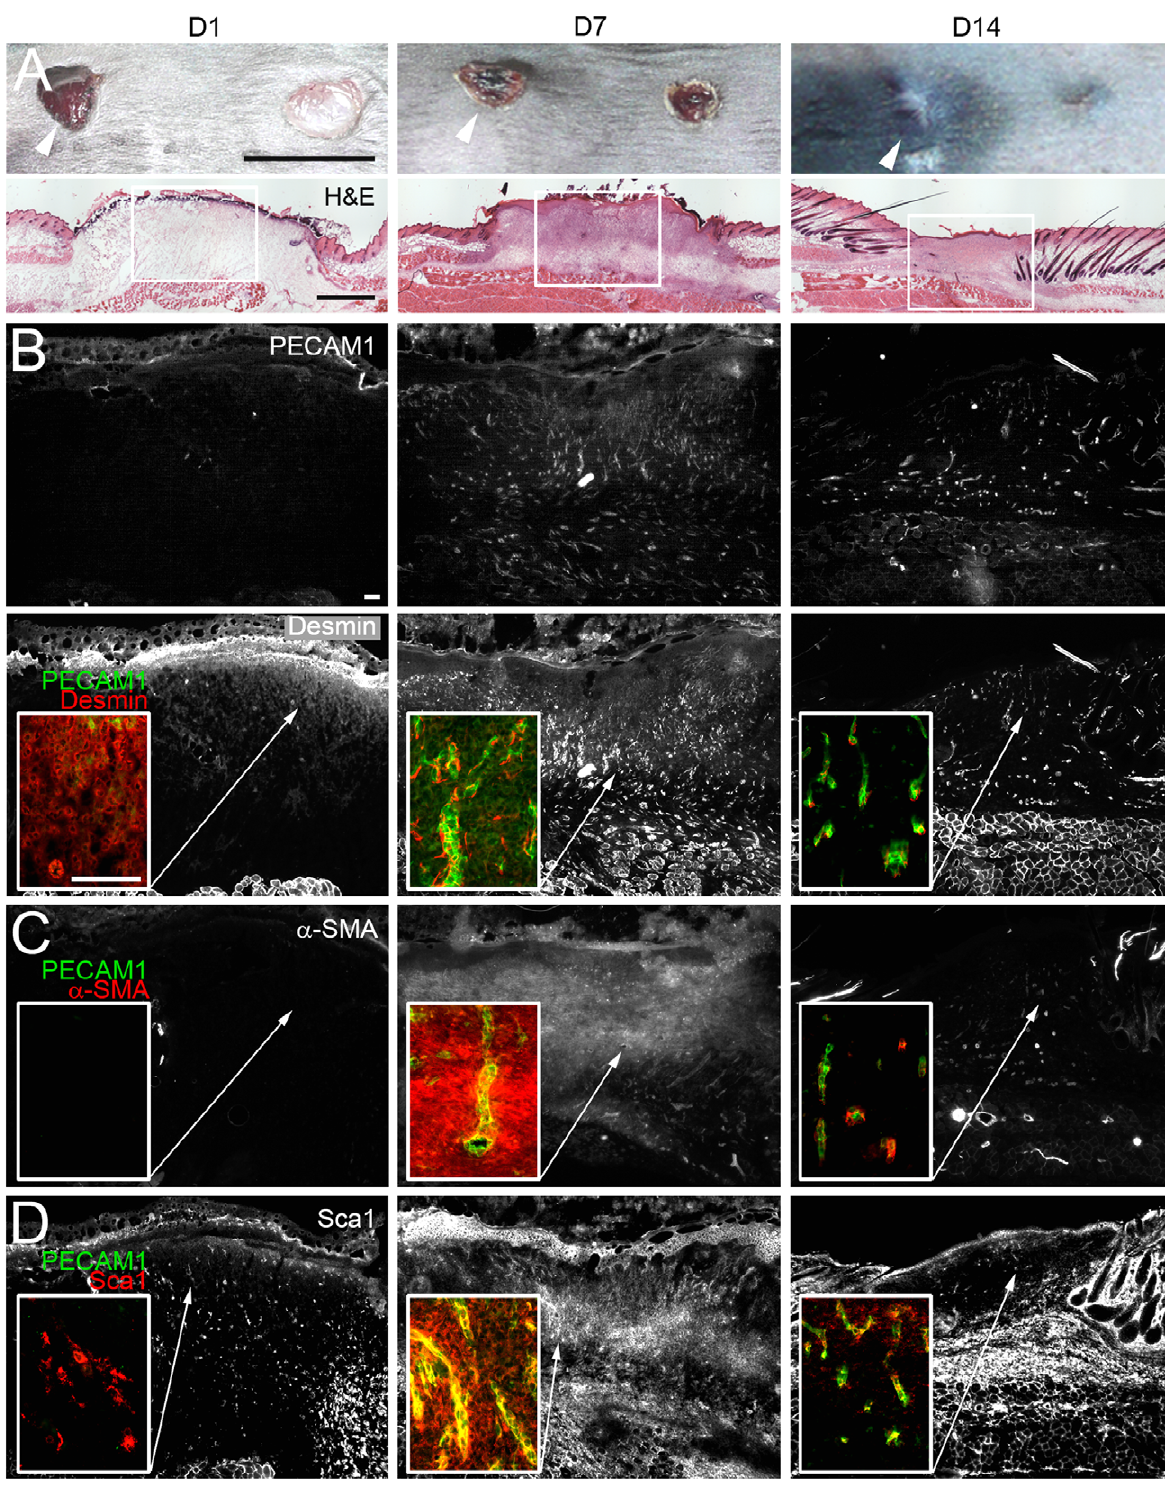
Figure 1. Expression of perivascular and endothelial cell-specific markers in wound repair. Analysis of PECAM1, desmin, a -SMA and Sca1 expression in the wounded skin. (A) Dorsal view of full thickness wounds on the back skin of mice one (D1), seven (D7) and 14 (D14) days post injury. Representative H&E-stained cryosections of selected wounds (arrowhead) during inflammation (D1), granulation (D7) and remodeling (D14) are shown. (B-D) Immunostaining of (B) PECAM1/desmin, (C) PECAM1/ a -SMA or (D) PECAM1/Sca1 expression at the different stages of wound healing. The individual monochrome signals for PECAM1, desmin, a -SMA and Sca1 are shown in overviews. Squares within the images represent closeups of overlays for the PECAM1/desmin, PECAM1/ a -SMA PECAM1/Sca1 stainings (B-D). Bars 1 cm (A, top), 1 mm (A, lower panel), 100 m m (B).